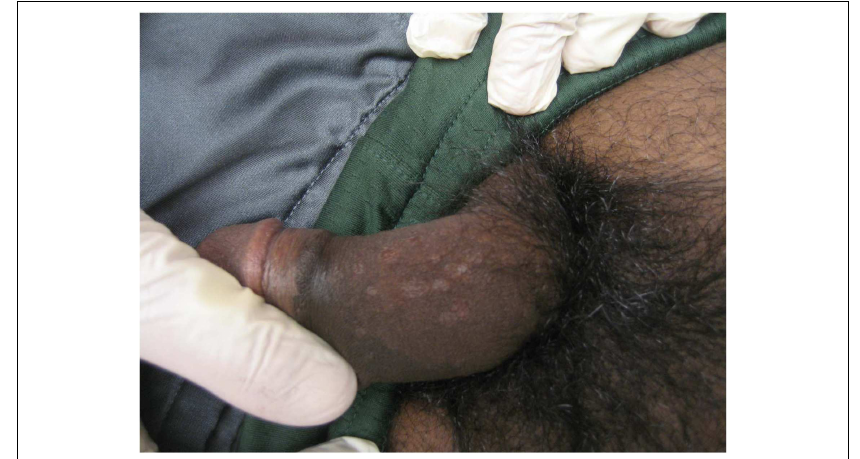
FIGURE 1 | Rash associated with secondary syphilis resembling allergic reaction